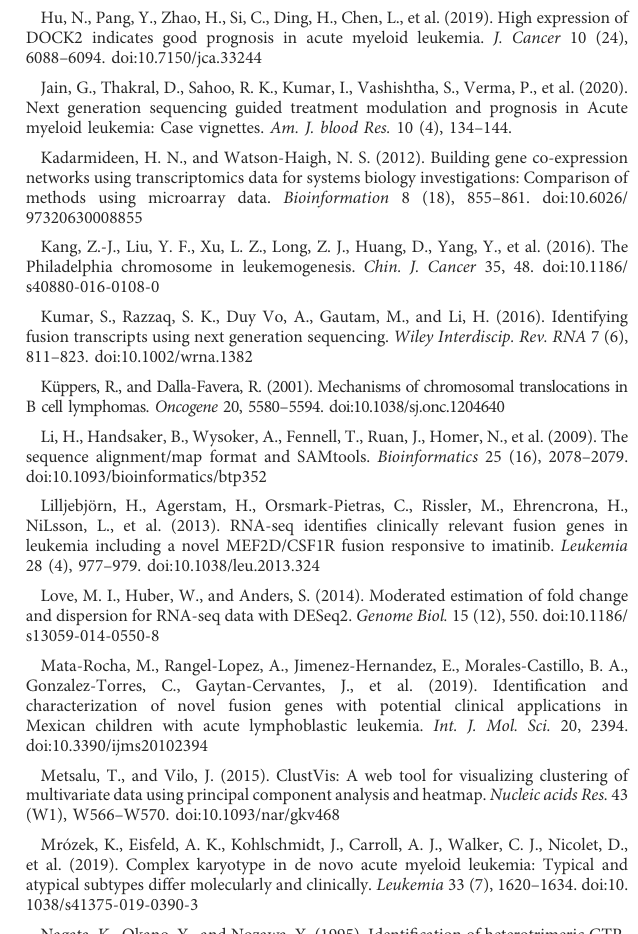
AnIGVsnapshotshowingtheBCR-ABL1fusiontranscriptwithreadsfromthe alignment fi le mapping to the junction.